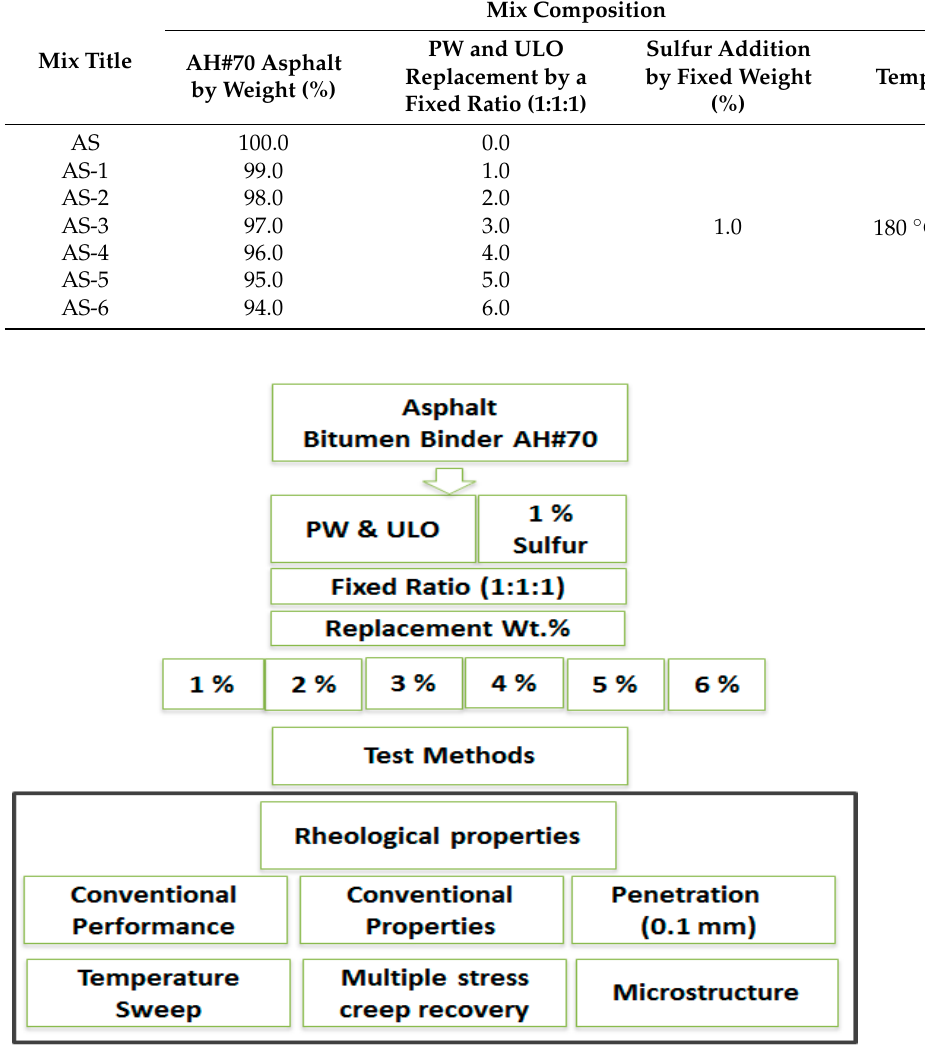
Figure 2. Scientific diagram of practical work.